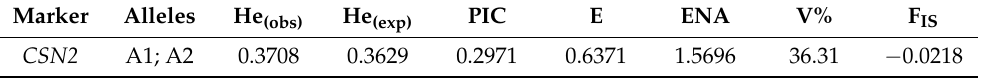
Table 5. The population genetic indices for CSN2 gene in a population of Slovak Holstein cattle.